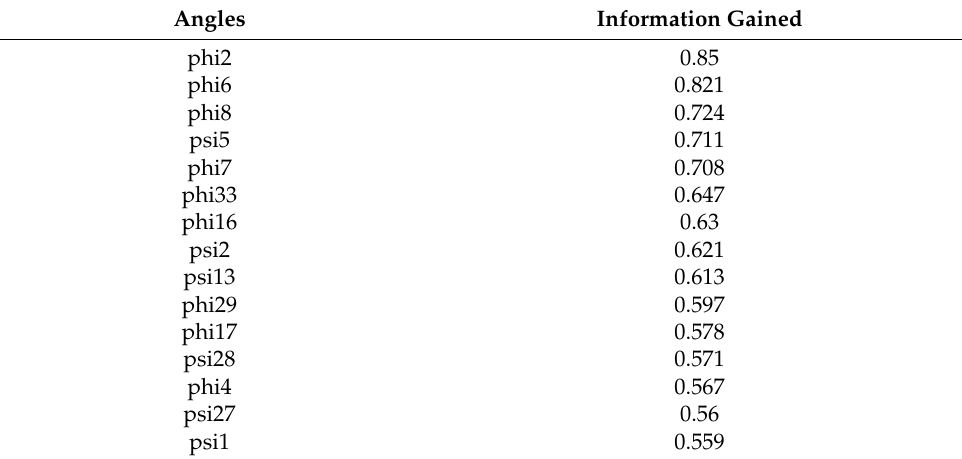
Table 5. Results of Ranking Entire Data Set by